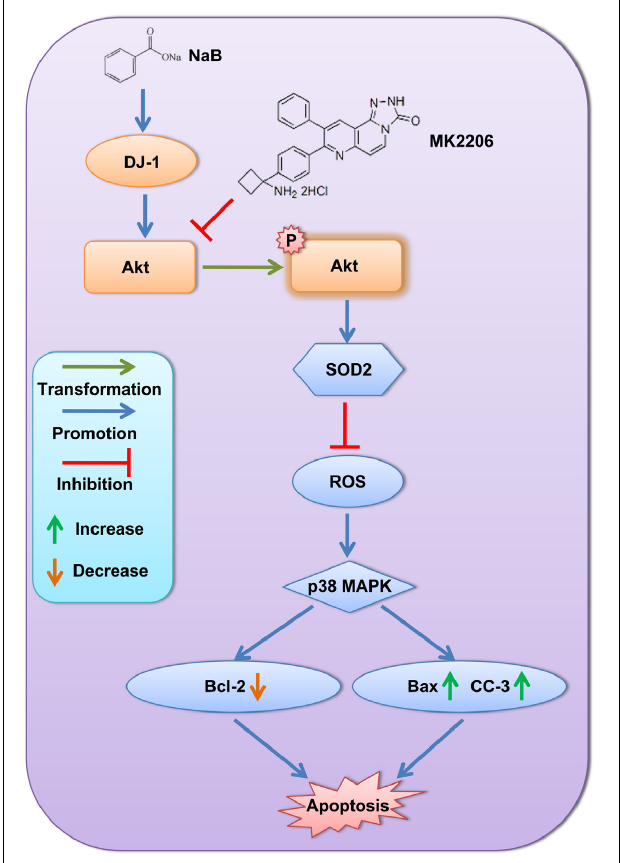
FIGURE 12 | Schematic map of the potential signaling pathway showing alleviation of neuronal apoptosis by NaB via DJ-1/Akt-related anti-oxidative stress